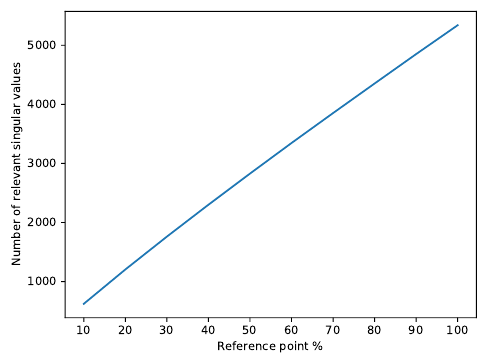
Figure 1. Mean of the number of relevant singular values in matrix D x as the function of reference points with dataset Computer